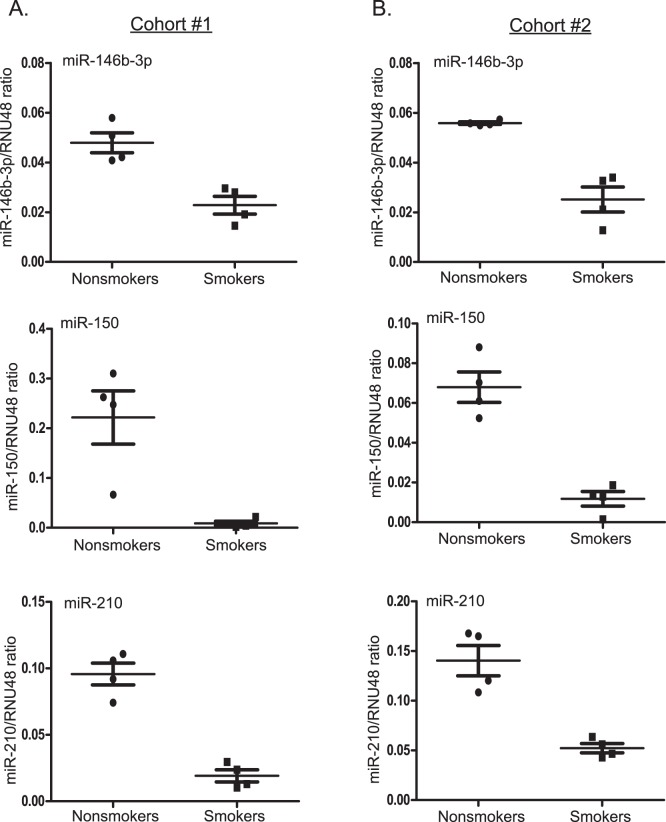
Expression profiling results were validated for select miRNAs in samples from the original alveolar macrophage donors and additional, non-redundant donors.Individual miRNA qRT-PCR expression assays were used to evaluate the expression of miR-146b-3p, miR-150, and miR-210. Expression of these miRNAs was determined using A) RNA analyzed previously in the TLDA assays (cohort 1) and B) RNA obtained from an independent set of donors (cohort 2). The mean expression with SEM of each miRNA is shown as a ratio to RNU48 for each sample.